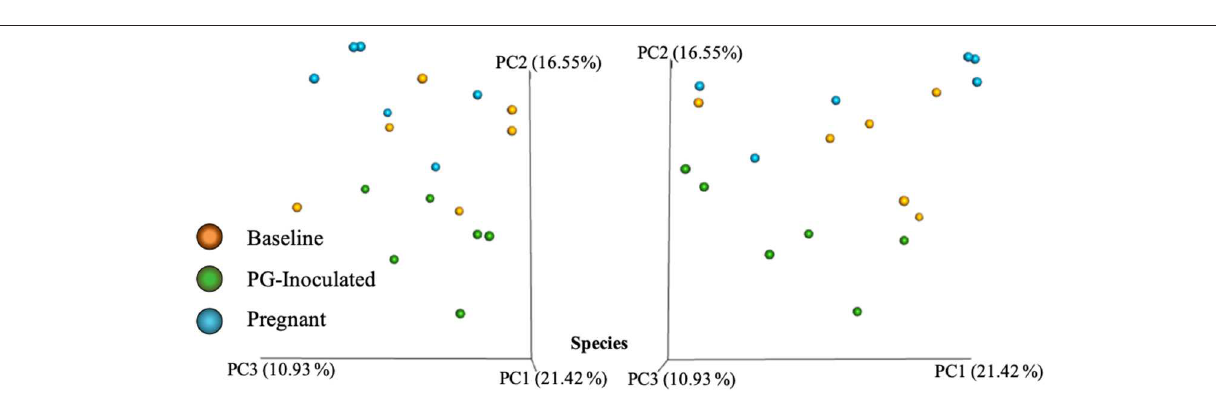
of decreasing population proportion: S. sanguinis, S. mutans,